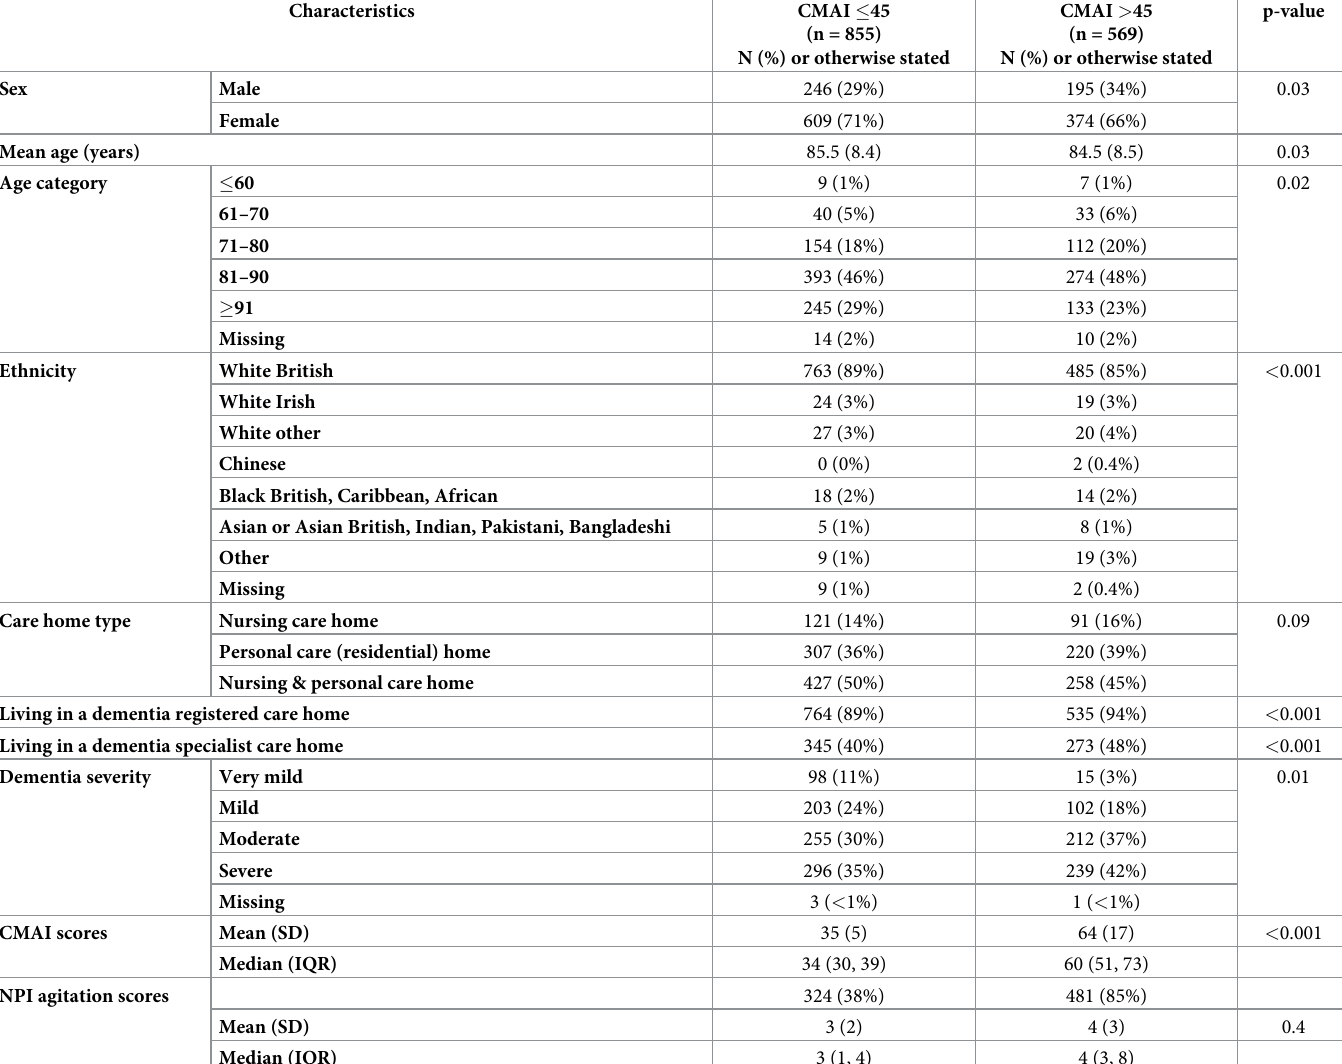
Table 1. Demographic characteristics by CMAI scores.